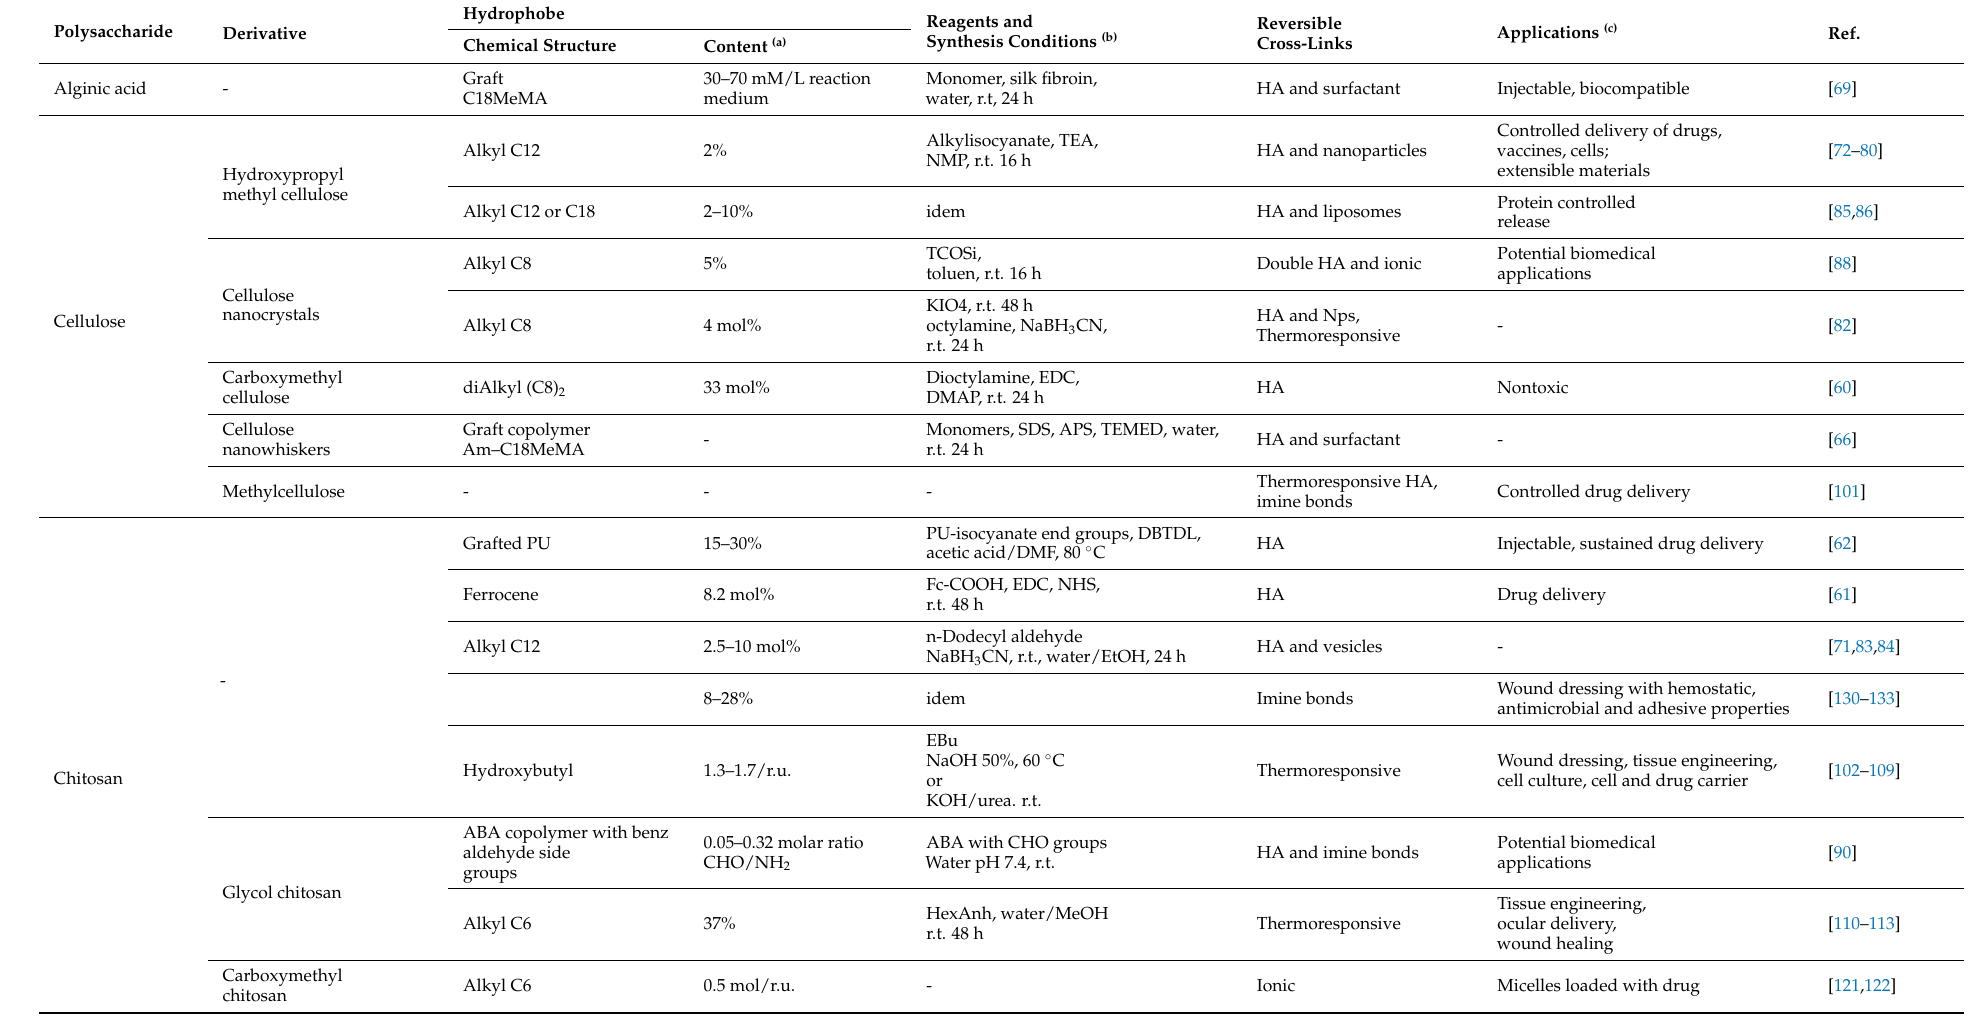
Table 1. Amphiphilic polysaccharides and their hydrophobic associations (HA) involved in the preparation of self-healing